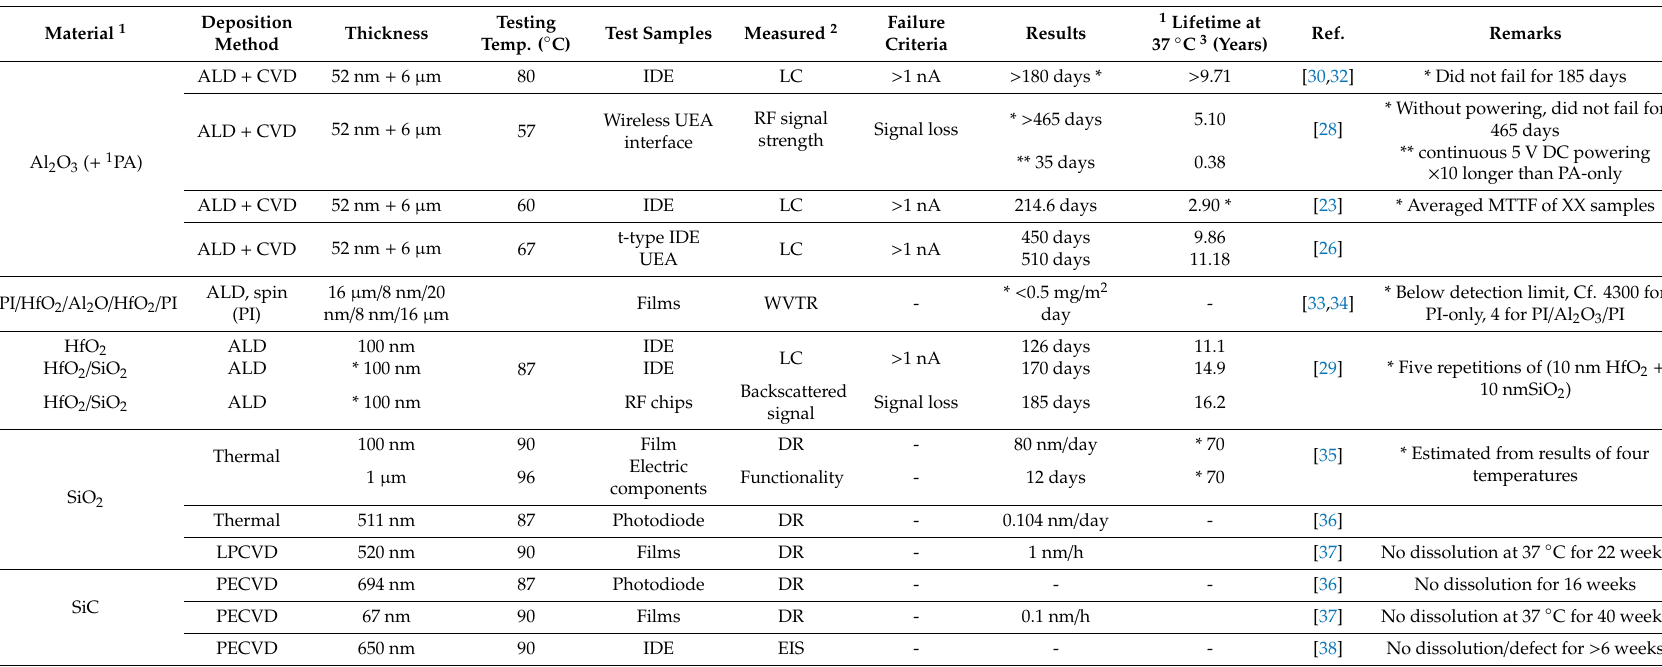
Table 1. Summary of selected results from long-term reliability tests of encapsulation with various inorganic